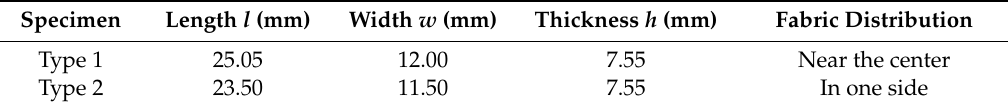
Figure 2. Optical images of ( a ) Type 1 specimen and ( b ) Type 2 specimen. Table 1. Final dimensions and fabric distribution.